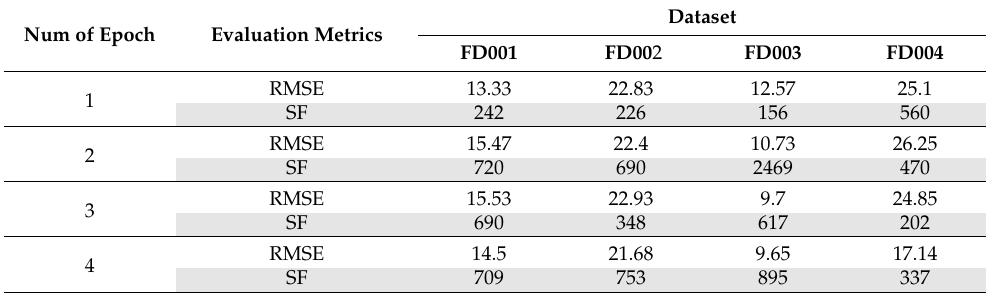
Table 4. Performance analysis of the synchronous FedLSTM.